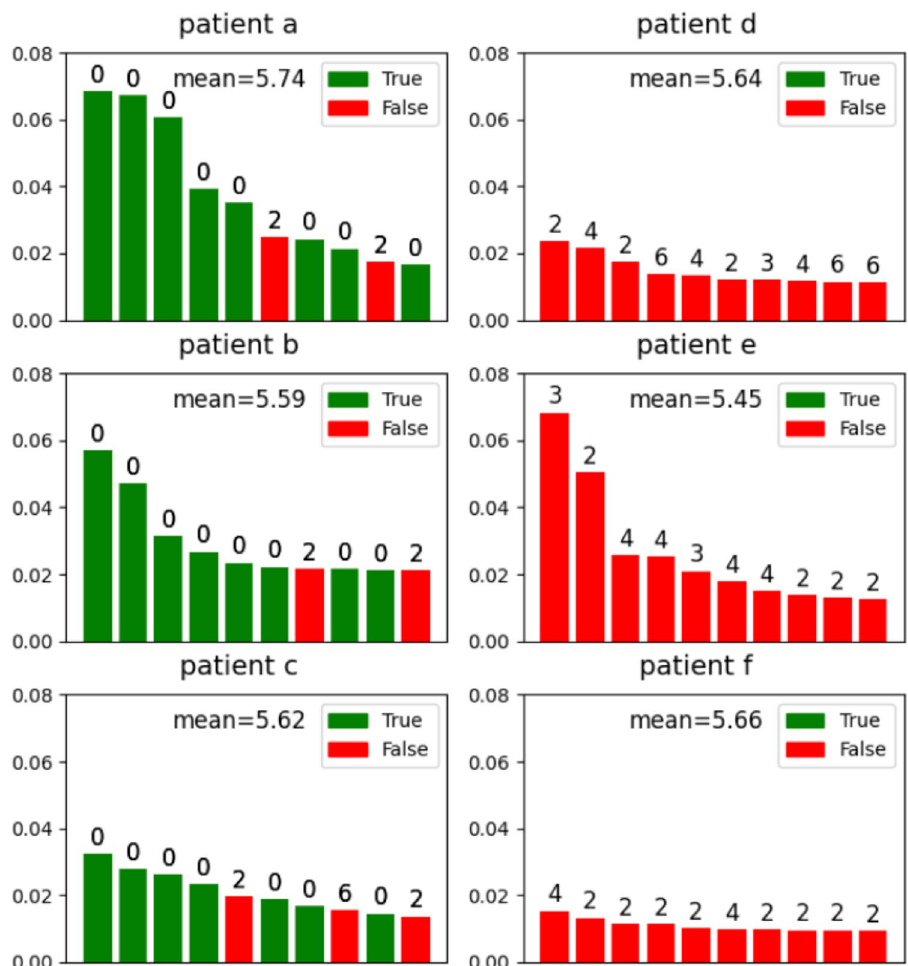
Figure 5. The distance from imputed ATCs to true ATC codes for the 3 most accurately imputed patients and the 3 most inaccurately imputed patients. Similar to Fig. 4, each panel displays the information of the top 10 imputed ATC drugs. The height and color of a bar indicates the imputed probability and whether it is correct. Annotated above each bar is the shortest distance from each imputed ATC to any of the observed ATC codes. As a reference, the mean distance indicated in each panel is the average distance from all of the ATC codes to observed ATC codes of the same patient.